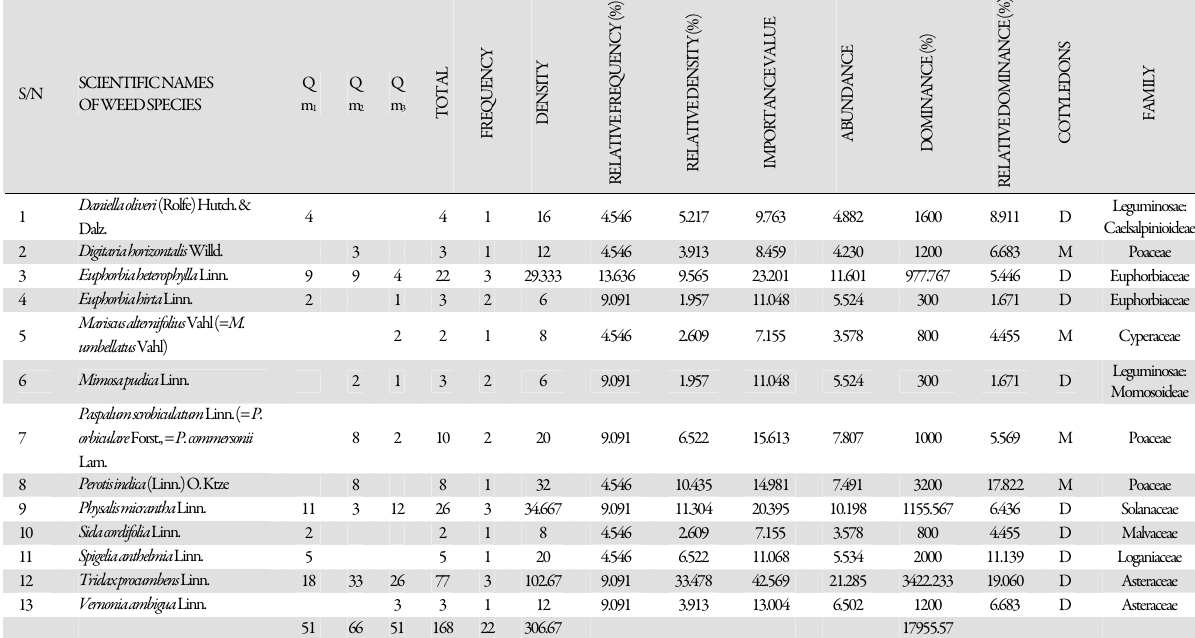
Tab. 2. Weed flora and species parameter for maize plot at 6WAP